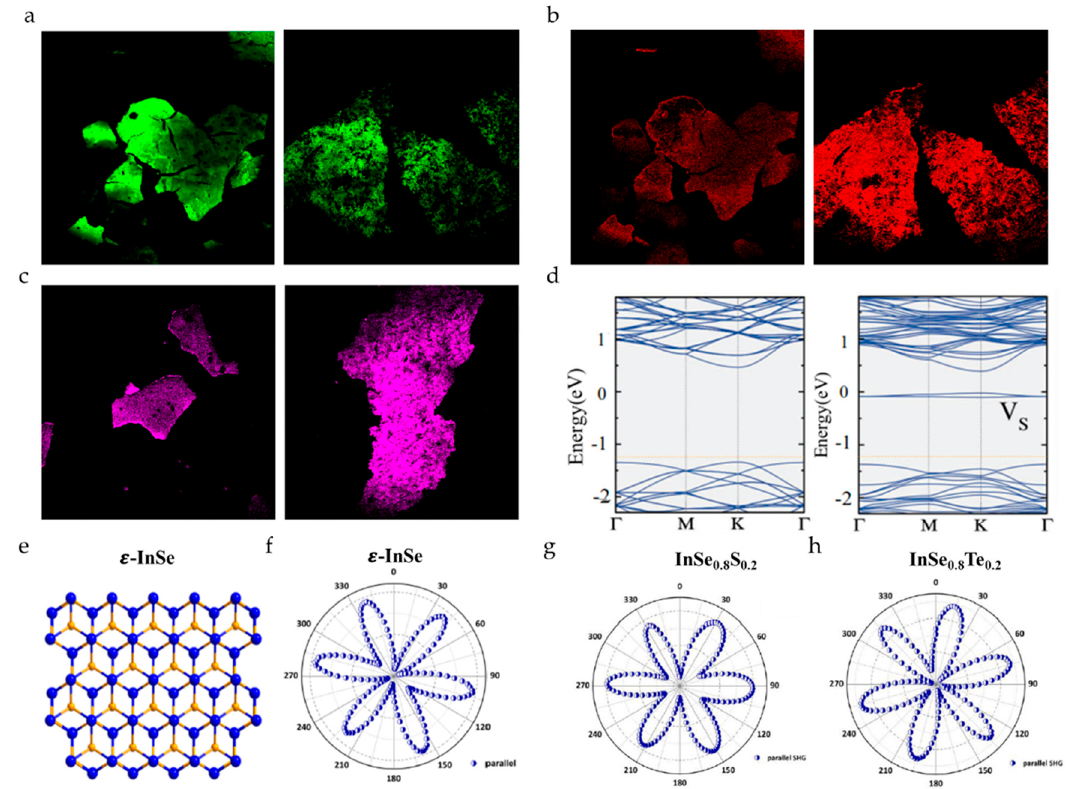
Figure 8. Zero-dimensional defect: ( a ) Left panel: TPEF of g-C 3 N 4 ; Right panel: TPEF of defective g-C 3 N 4 . ( b ) Left panel: CARS of g-C 3 N 4 . Right panel: CARS of defective g-C 3 N 4 . ( c ) Left panel: SHG of g-C 3 N 4 . Right panel: SHG of defective g-C 3 N 4 . Reproduced from [43], with permission from American Chemical Society, 2019. ( d ) Left panel: Discrete fourier transform (DFT) calculations of electronic bands for pristine WS 2 . Right panel: DFT calculations of electronic bands for W 16 S 30 (VS: vacancies replacing sulfur). Reproduced from [83], with permission from Elsevier, 2018. ( e ) Schematic view of ε -InSe. Polarization-resolved SH intensities of ( f ) pure InSe ( g ) InSe 0.8 S 0.2 and ( h ) InSe 0.8 Te 0.2 as a function of the excitation laser polarization against the crystalline lattice direction Reproduced from [43], with permission from American Chemical Society, 2019.